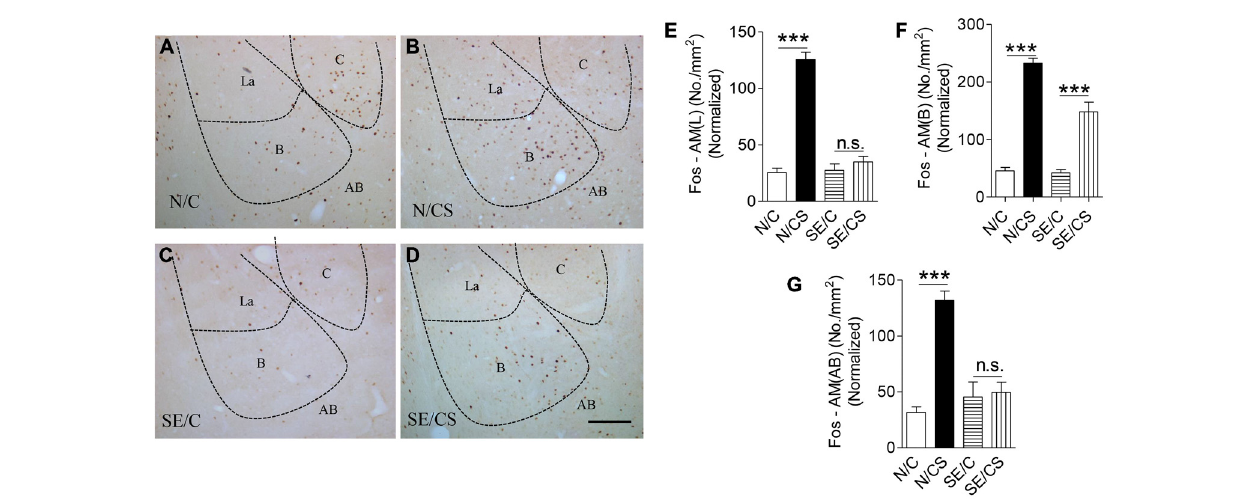
FIGURE 4 | Increased expression of c-Fos at the BLA upon contextual learning and memory test. Representative images show c-Fos immunopositive neurons in the amygdala of the four groups of mice after fear memory test at Day 3 (A–D) . Graphs (E–G) showing the number of c-Fos-immunopositive cells per area (mm 2 ) in the lateral (E) basal (F) and accessory basal (G) nuclei of the amygdala after fear memory test at Day 3 in the four groups of mice normalized with neuronal loss in the SE2m group (ANOVA post hoc test, ∗∗∗ p < 0.001), Scale bar = 100 µ m in (D) applies to (A–C) . La, Lateral; B, Basal; C, Central; AB, Accessory Basal.